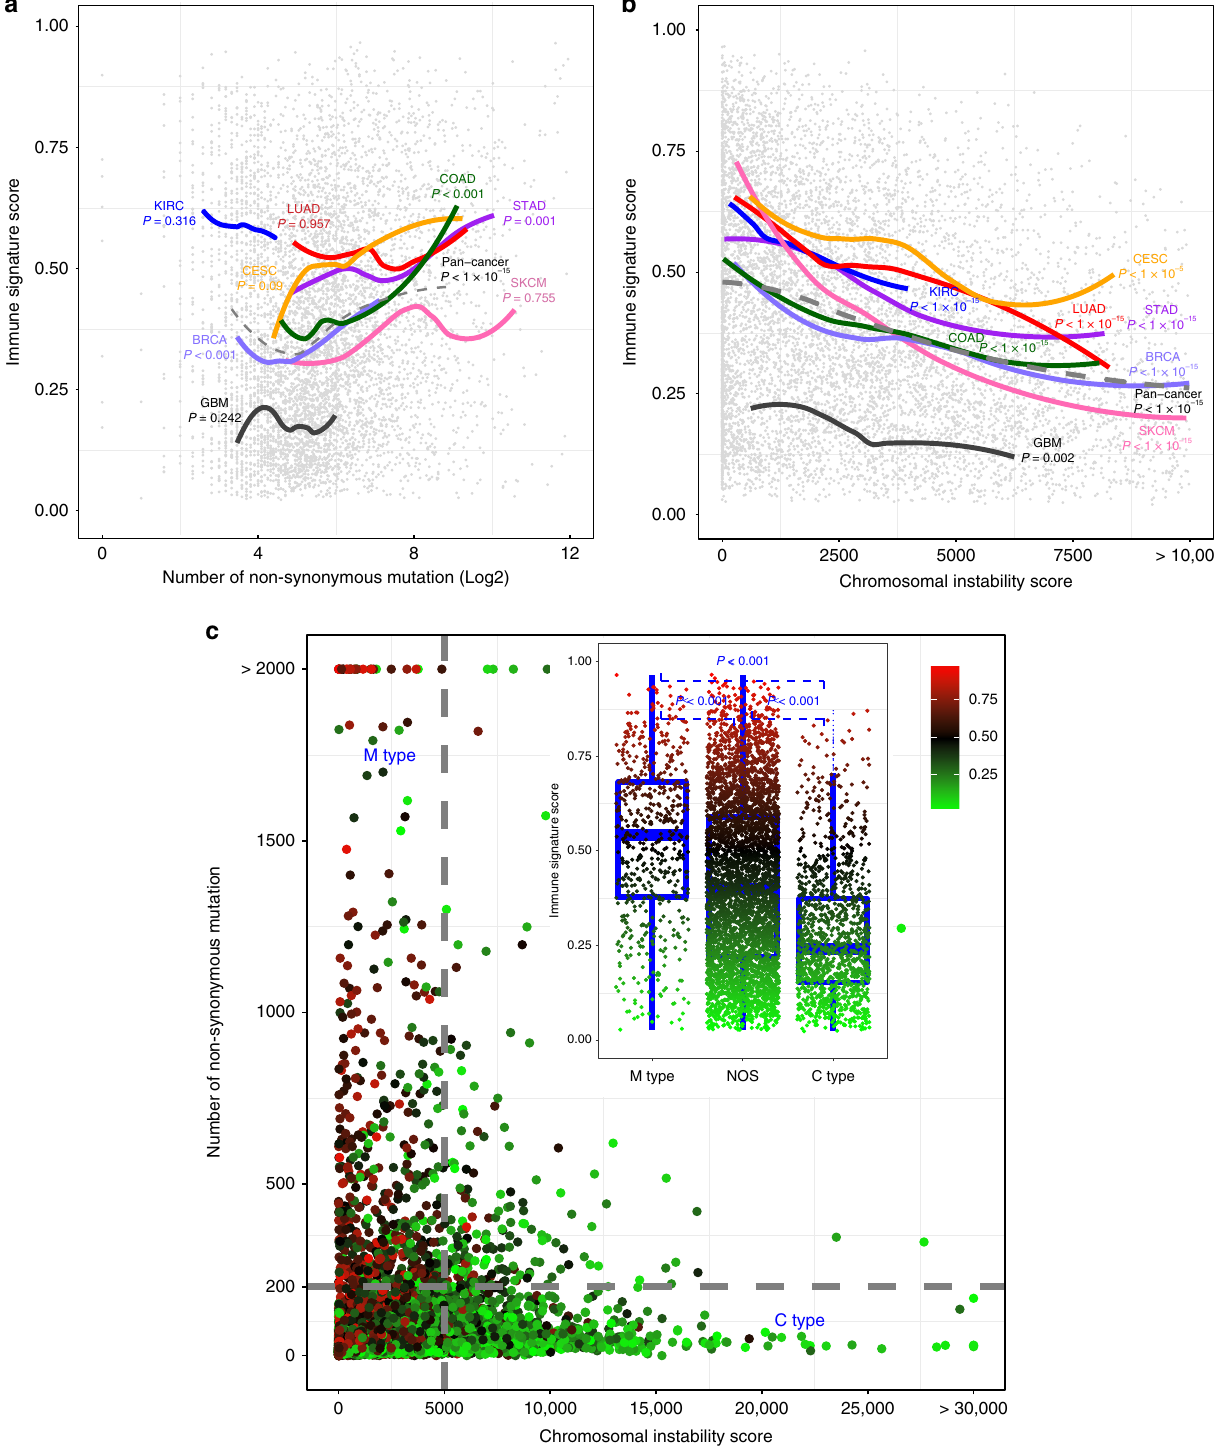
Fig. 4 Two types of tumors distinct in genomic alterations and response to immunotherapy. a Scatter plots between mutation rates and IS scores. Dotted line represents global regression curve between mutation rates and IS scores in all cancers. Solid lines represent local regression curves between mutation rates and IS scores in each cancer as indicated. b Scatter plots between chromosome instability (CIN) scores and IS scores. Dotted line represents global regression curve between two scores in all cancers. Solid lines represent local regression curves between two scores in each cancer as indicated. CIN scores were de fi ned by sum of square of gene-level gistic 2 value. c Scatter plots between mutation rates and CIN scores. Size and colors of dots represents IS scores as indicated in reference index. The tumor with high mutational burden (M type) is de fi ned by number of non-synonymous mutation more than 200 as described in previous study, whereas the tumor with high chromosomal instability (C-type) is de fi ned by CIN score more than 5000. Otherwise, tumors are classi fi ed as not otherwise speci fi ed (NOS). IS score according to M type or C type is summarized inside the graph. Blue lines in the box represent upper 75%, median, and lower 25% values of subtype. See also Supplementary Figs. 20 −